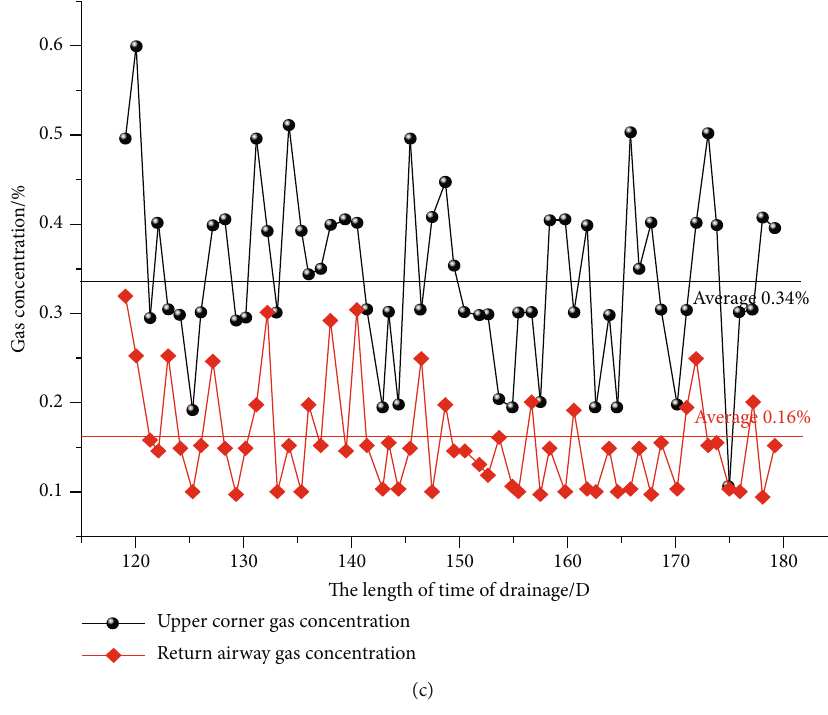
Figure 9: Drilling and drainage concentration level from the